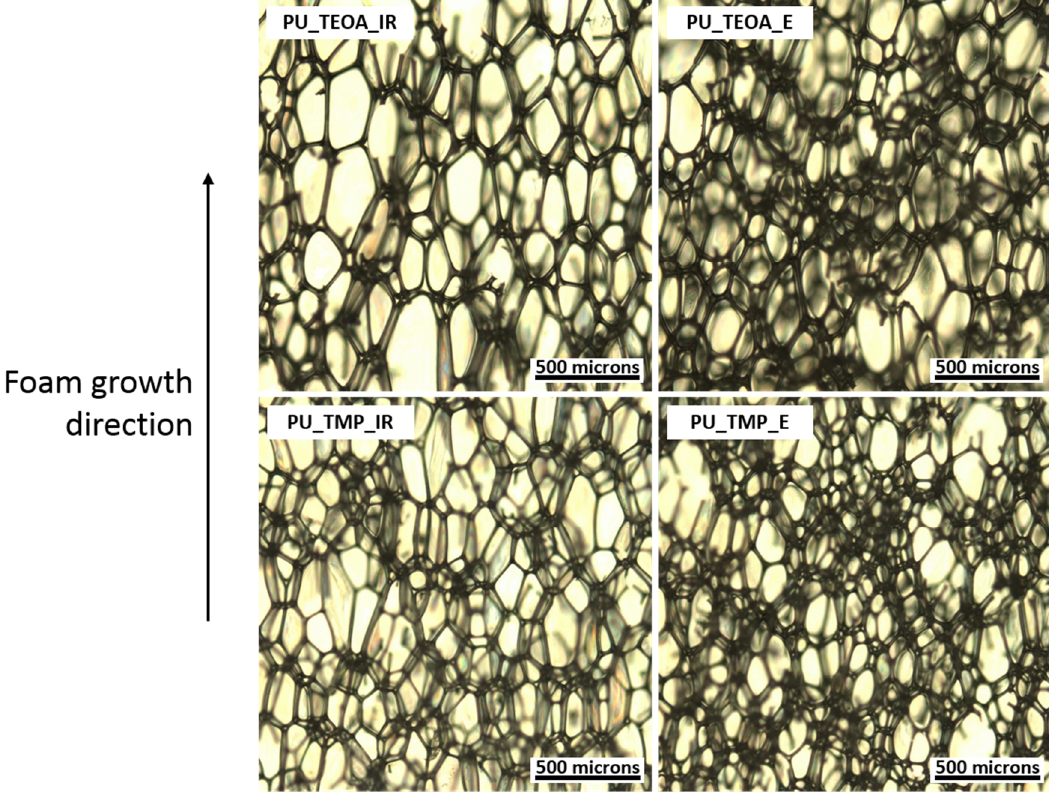
Figure 6. Microscope images of developed rigid polyurethane (PU) foams. The compression strength and compression modulus of ETOFA_TEOA_IR-, ETOFA_TEOA_E-, ETOFA_TMP_IR- and ETOFA_TMP_E-based rigid PU foams were measured in parallel and perpendicular to foaming direction and are depicted in Figure 7. The data have been normalised to the average apparent density of 40 kg/m 3 , according to Hawkins et al. [56], to compare the mechanical properties. Developed rigid PU foams had significant anisotropicity as the mechanical properties varied depending on the test- ing direction. Anisotropicity is typical for rigid PU foams that are obtained in open-type mould. Rigid PU foam cells tend to elongate with the foaming direction, as seen in Figure 6. Nevertheless, the compression strength was ~0.2 MPa, which is typical for this type of material applied for civil engineering [57]. A slight difference can be distinguished when the mechanical properties are com- pared regarding the used epoxidation method (ETOFA_IR and ETOFA_E). Rigid PU foams obtained from ETOFA_E showed a slight increase in compression properties due to the higher functionality of the derived polyols compared to polyols obtained from ETOFA_IR. A higher functionality of bio-polyol will result in the higher cross-link density of the obtained PU polymer matrix, which will increase the mechanical properties of rigid PU foam. In addition, the increase in mechanical properties can also be explained by slightly smaller cell size rigid PU foams obtained from ETOFA_E as depicted in Figure 5.